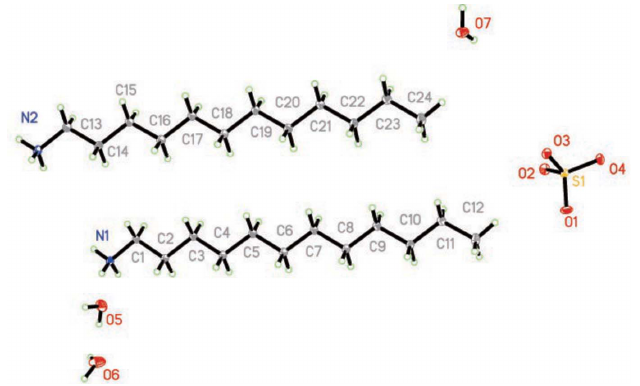
Figure 1 A view of the asymmetric unit of the title compound showing the atom numbering with 30% displacement